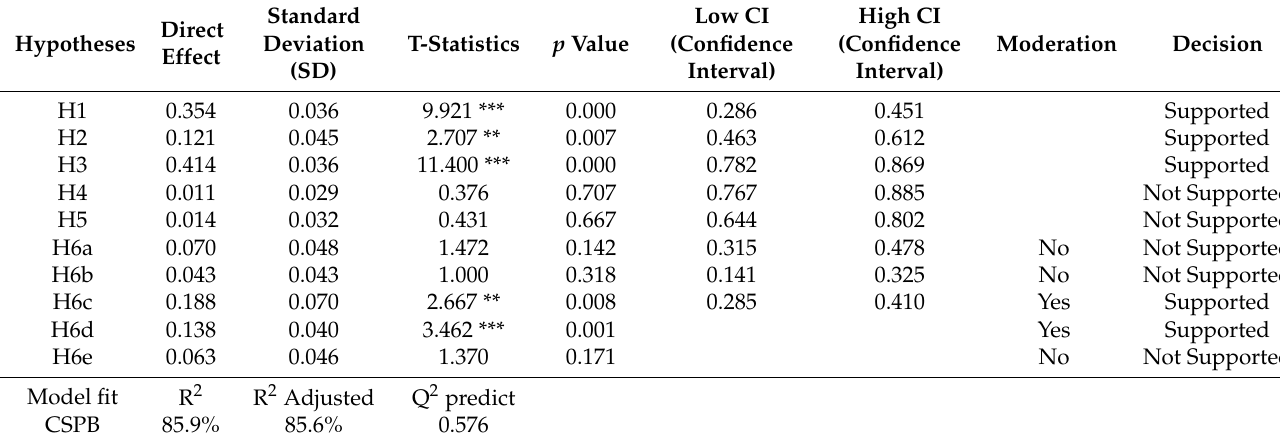
Table 3. Results of research hypotheses and model fit.